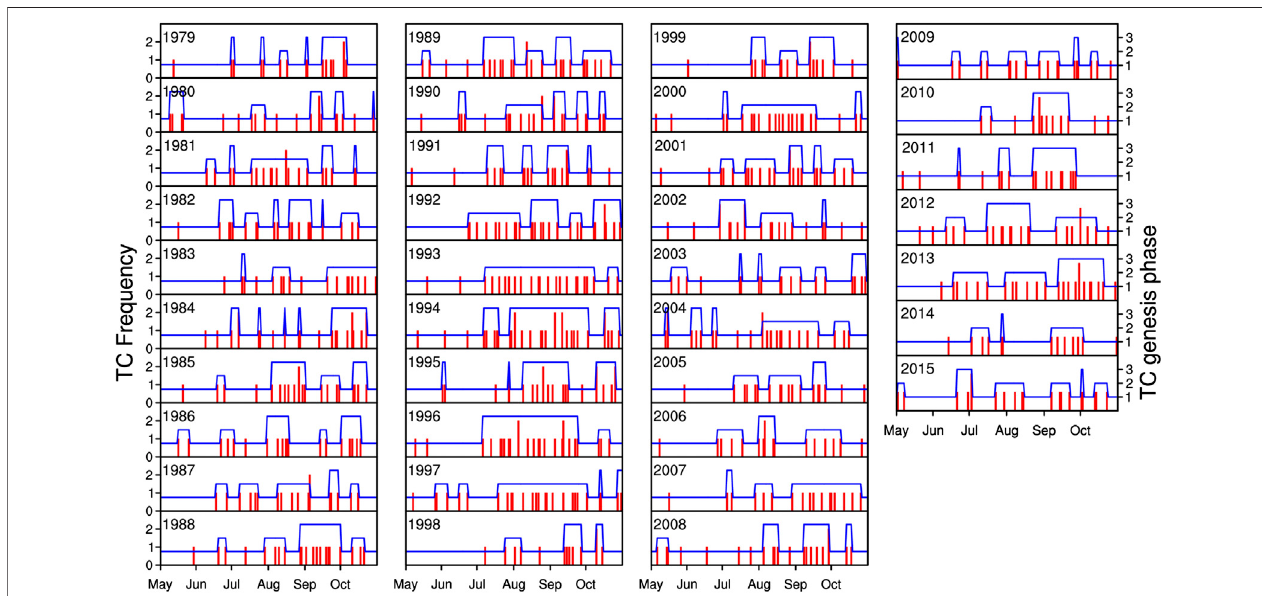
FIGURE 1 | The numbers of TC genesis (red column) and the MTC phase sequences during May to October from 1979 to 2015. The numbers 1, 2, and 3 for the blue lines indicate the inactive phase, normal phase, and active phase of the MTC events, respectively.